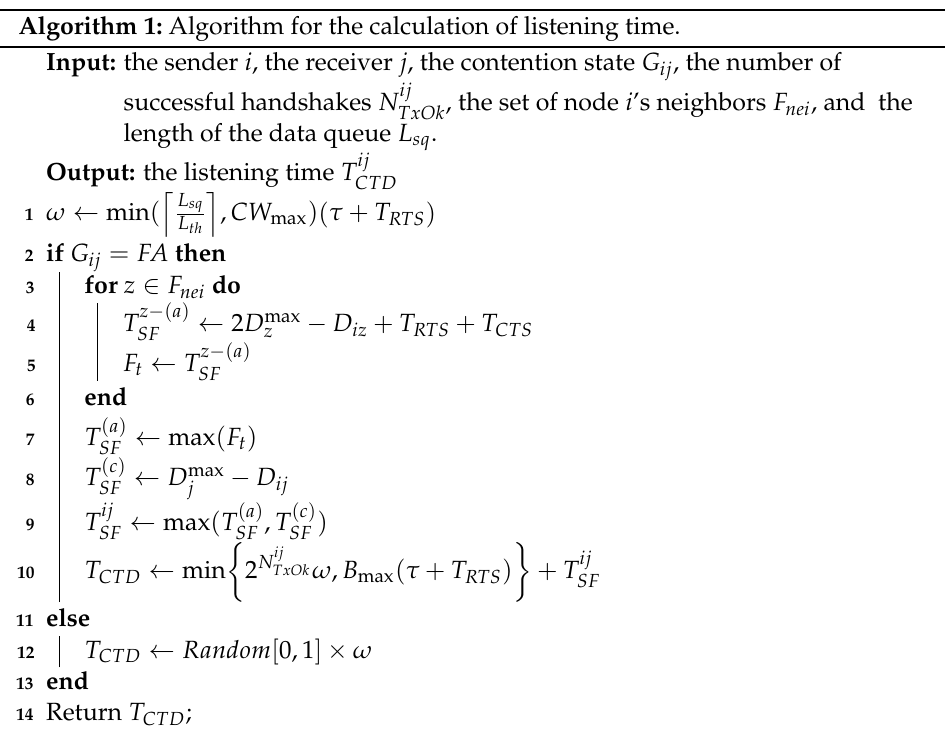
Algorithm 1: Algorithm for the calculation of listening